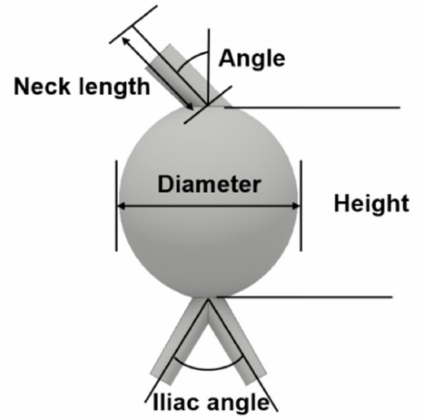
Figure 2. Geometry of abdominal aortic aneurysm